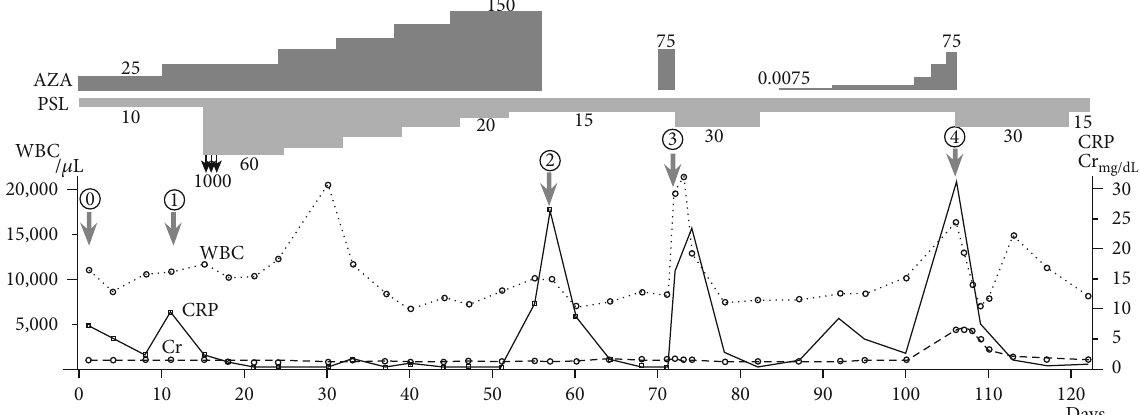
Figure 1: WBC, CRP, and Cr levels at about 4 months after the start of AZA and trends in PSL and AZA medication doses. Blood test results for the days indicated by the bold arrow are shown in Table 1. AZA: azathioprine; PSL: prednisolone.